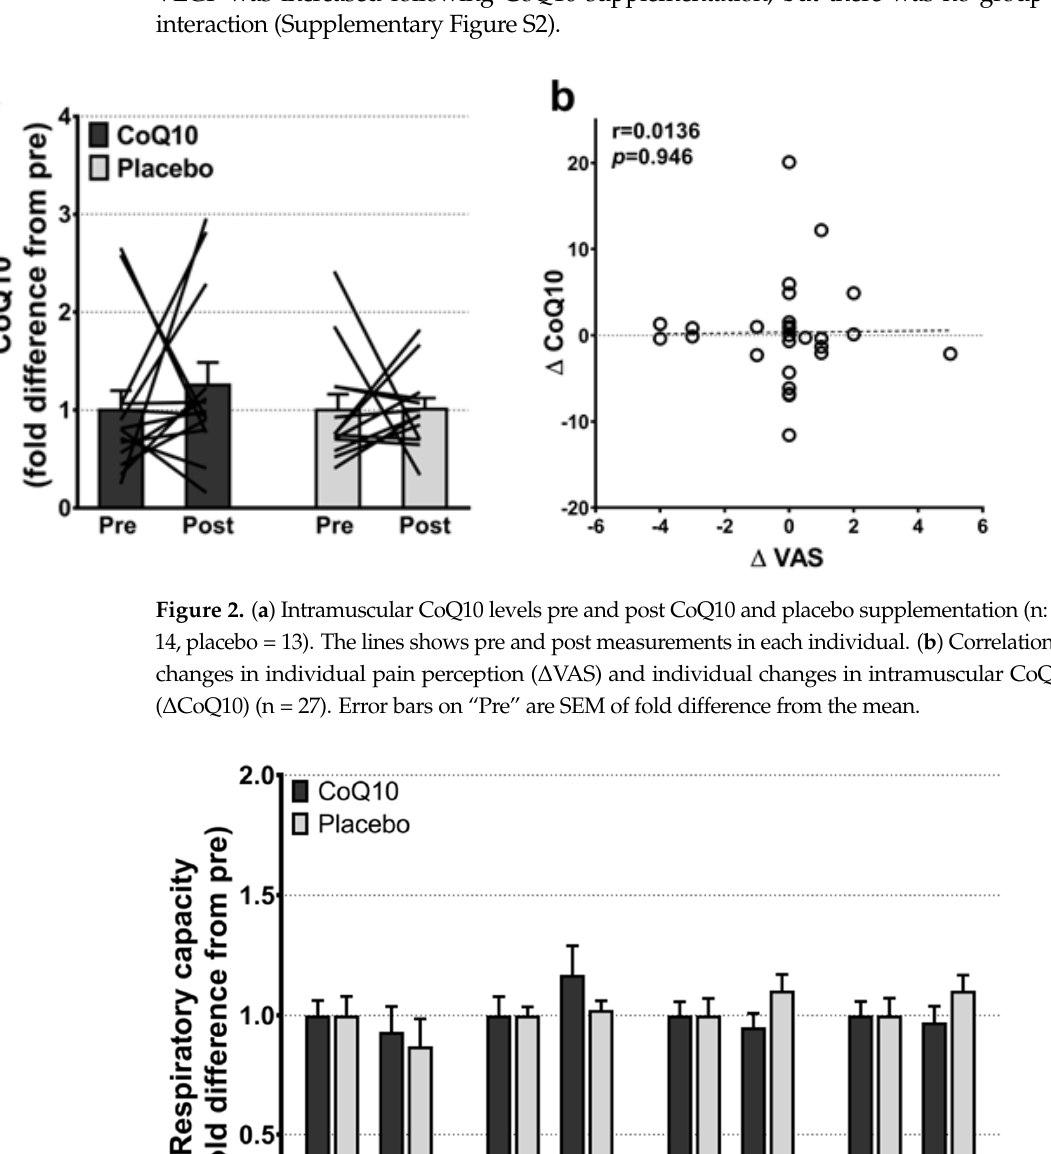
Figure 4. Maximal ROS (H 2 O 2 ) production with convergent electron flow through mitochondrial complex I and II. Data are expressed as fold difference from pre (mean ± SEM, CoQ10: 14, placebo: 14). The lines shows pre and post measurements in each individual. ROS: Reactive oxygen species. Error bars on “Pre” bars are SEM of fold difference from the mean. 5. Discussion Contrary to our hypothesis, we found no effects of oral CoQ10 supplementation on muscle CoQ10 levels or mitochondrial function, and individual changes in muscle CoQ10 levels did not correlate with individual changes in intensity of myalgia. We saw an in- crease in plasma CoQ10 concentration in the CoQ10 group, indicating adherence to the supplementation protocol. Randomized placebo-controlled trials are considered the gold standard to investigate treatment and intervention effectiveness as they limit the risk of bias due to confounders and placebo effects. Placebo-controlled trials have previously investigated the effects of